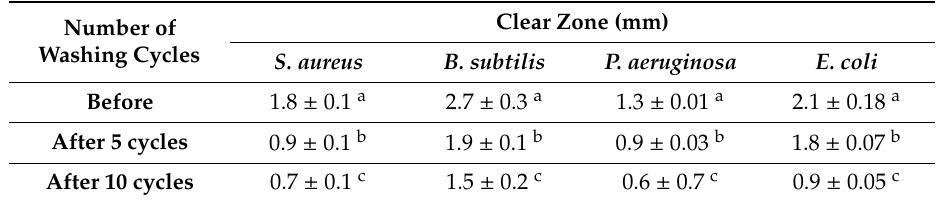
Table 1. E ff ect of repeated washing on the antibacterial properties of silver nanoparticle-finished fabrics by qualitative assessment